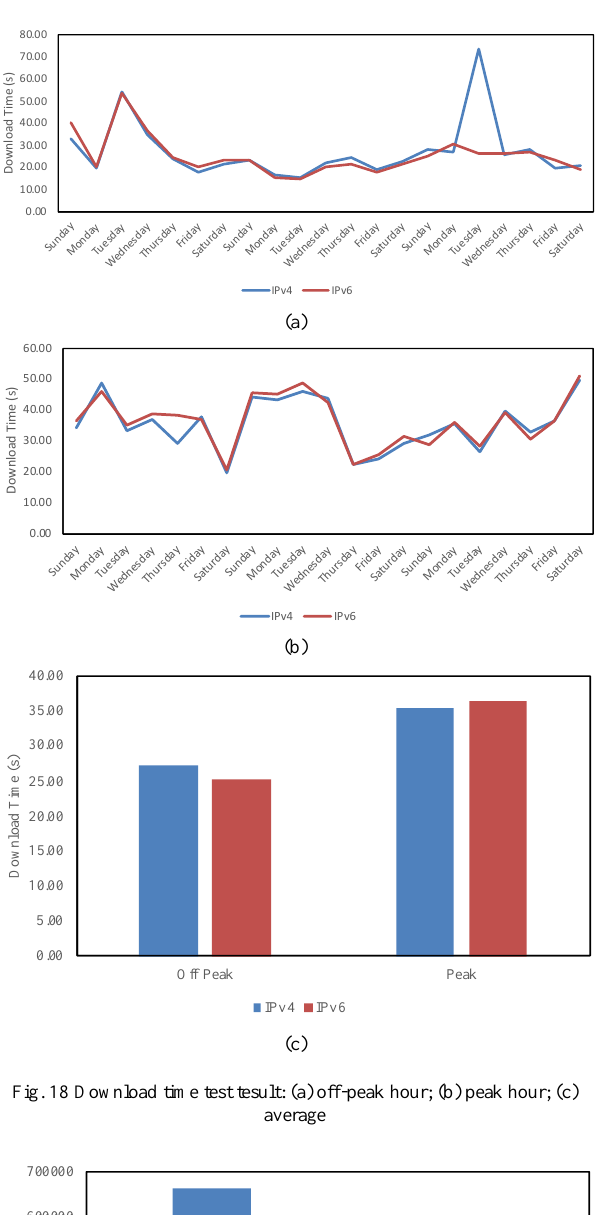
Fig. 18 Download time test tesult: (a) off-peak hour; (b) peak hour; (c) average